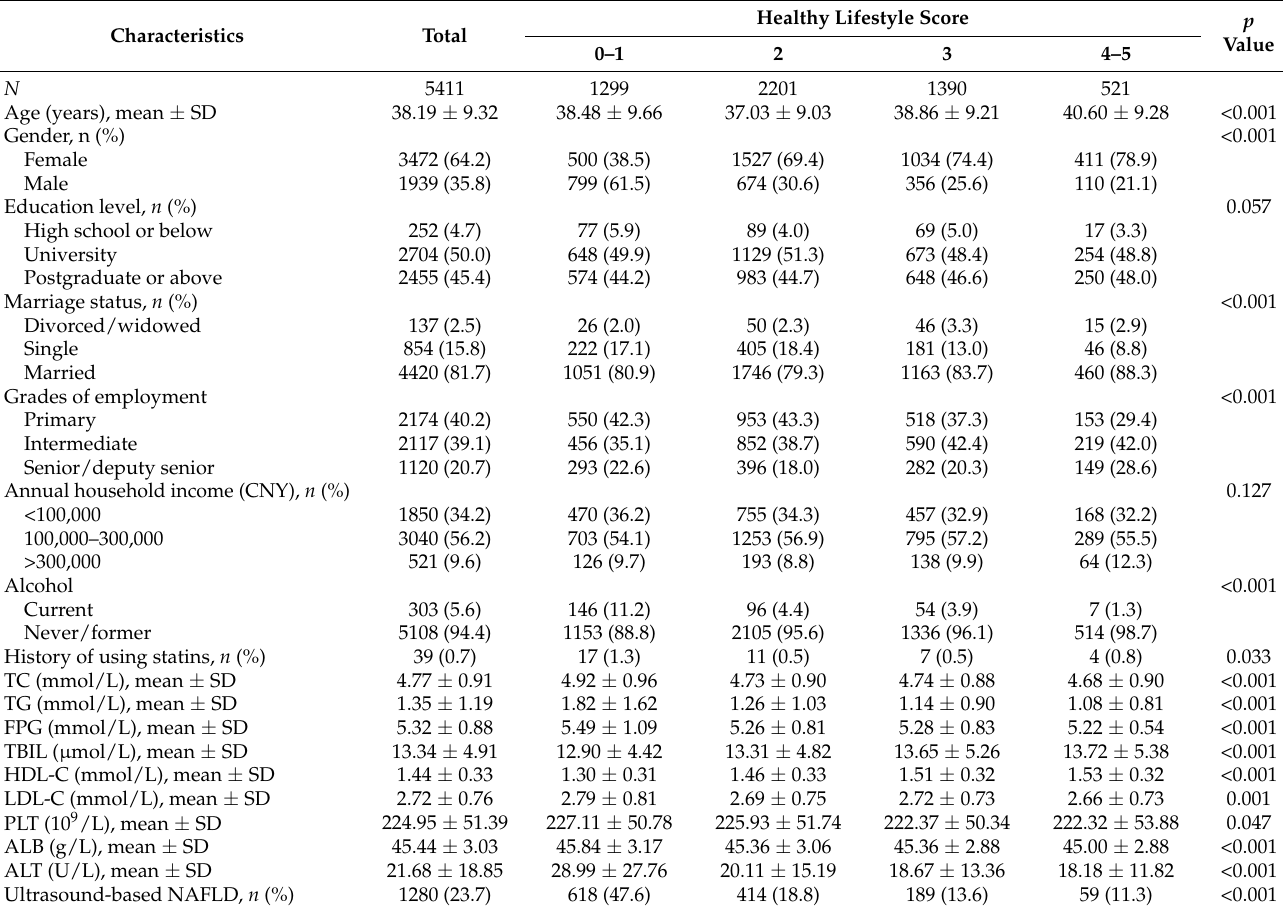
Table 1. Characteristics of the baseline